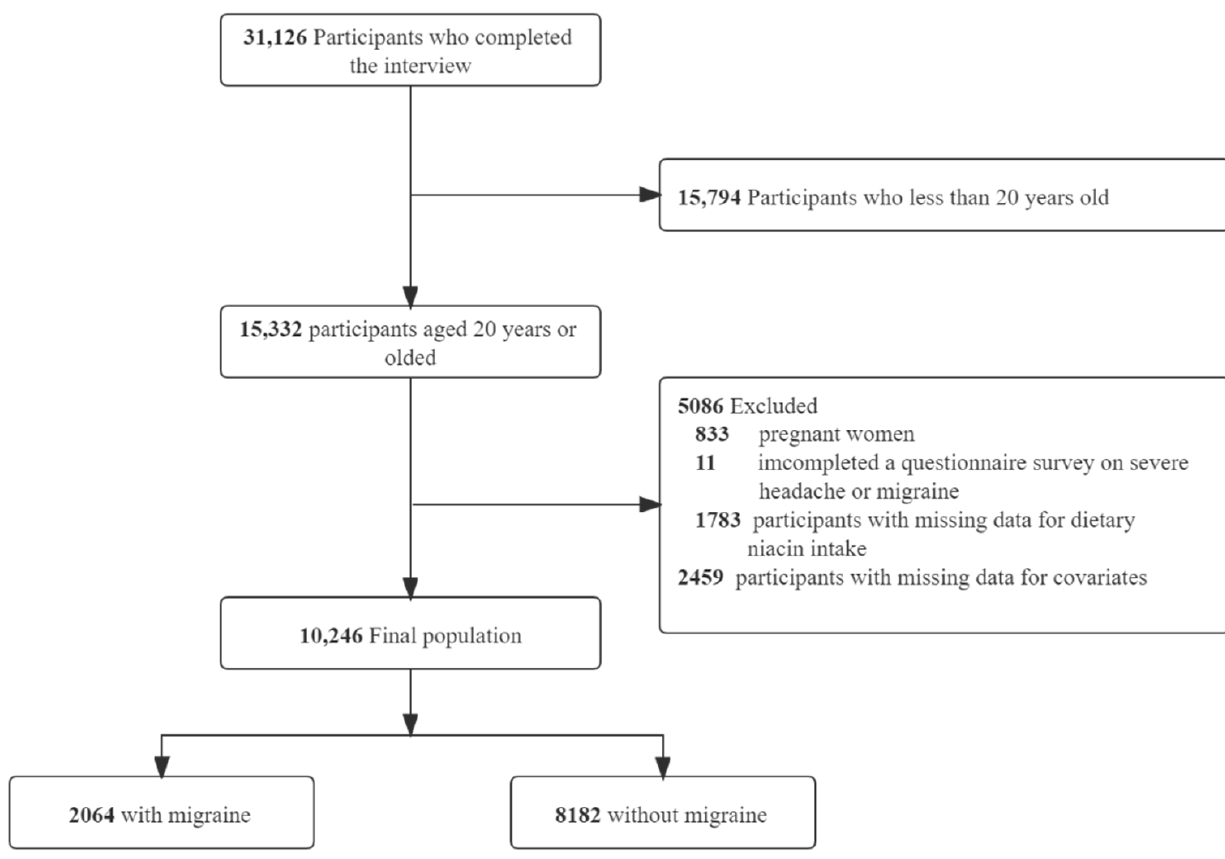
Table 1. Population characteristics by categories of dietary niacin intake.